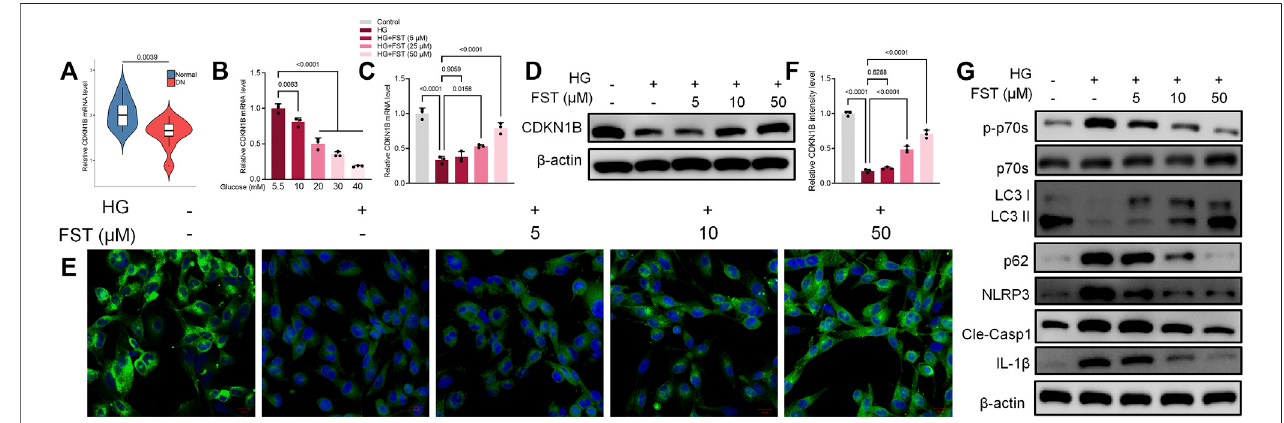
FIGURE 2 | Fisetin restored protein expression levels of CDKN1B in podocytes cultured in high glucose concentrations. (A) Nephroseq dataset showing the expression levelsof CDKN1B innormaltissues(toppanels)andindiabetickidneydisease(DKD). (B) Theexpressionlevelsof CDKN1B inpodocytesculturedindifferent concentrations of glucose was determined using qRT-PCR. (C,D) Determination of the expression levels of CDKN1B in podocytes using qRT-PCR and western blot after treatment with fi setin and culturing in high glucose concentrations (30 mM) for 48 h. (E,F) . Immuno fl uorescence staining of CDKN1B in podocytes after treatment with fi setin and culturing in high glucose concentrations (30 mM) for 48 h. Green indicates CDKN1B staining and blue indicates DAPI staining. (G) Determination of the expression levels of phosphorylated P70S6K, P70S6K, LC3, p62, NLRP3, cleaved caspase-1, and IL-1 β in podocytes using western blot after treatment with fi setin and culturing in high glucose concentrations (30 mM) for 48 h. Data are expressed as means ± SEM ( n =